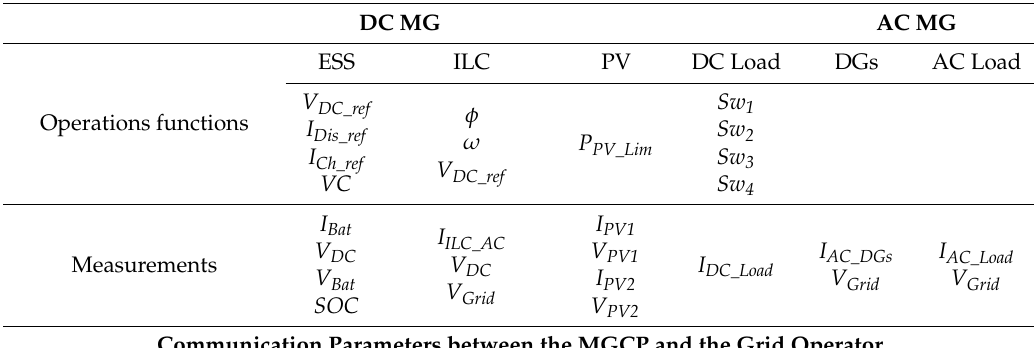
Table 1. Communication parameters of the